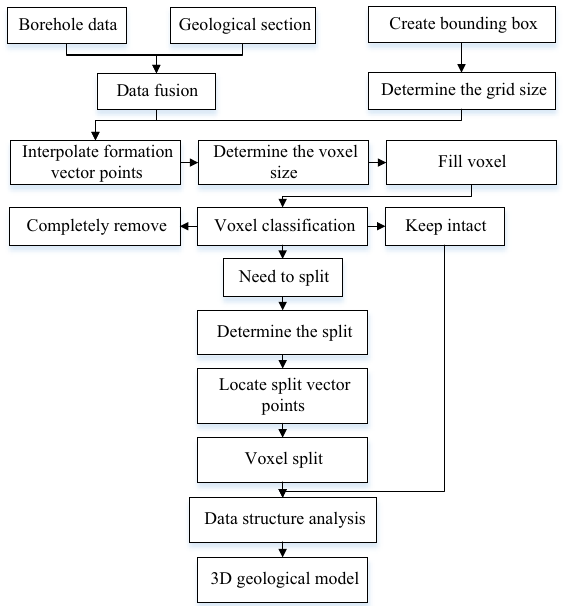
Figure 2. Modeling process.